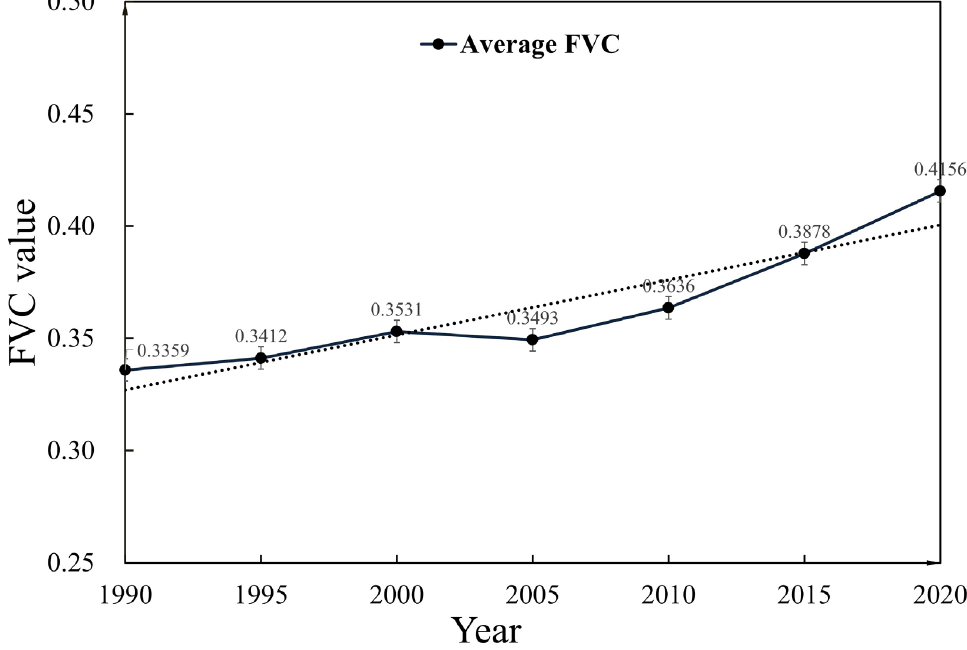
Figure 7. Changes in average FVC of provincial capital cities from 1990 to 2020.